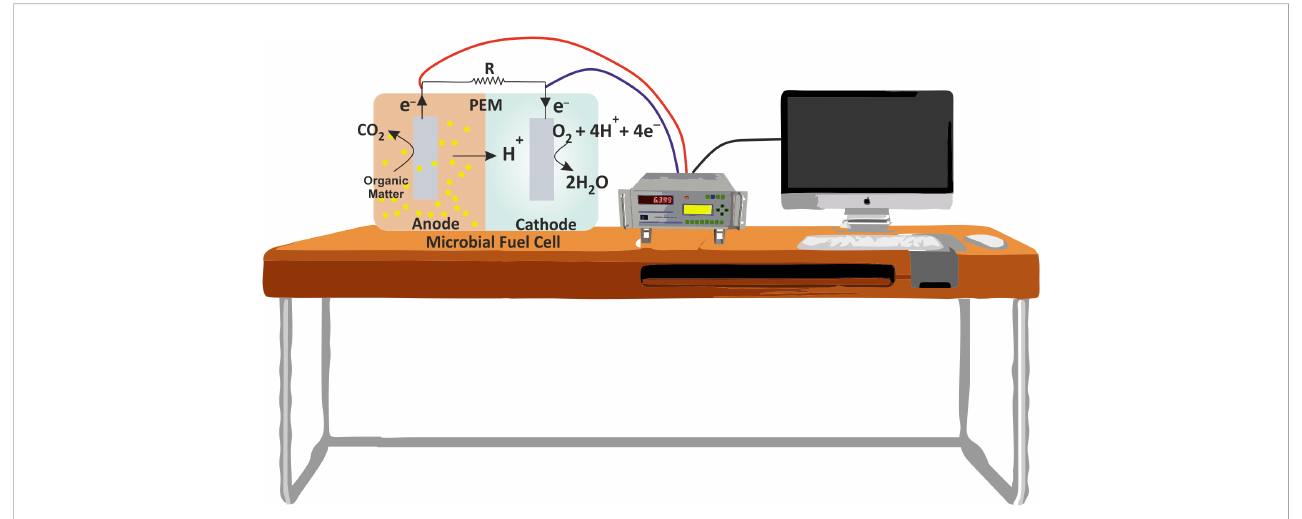
FIGURE 2 Schematic showing a typical MFC and its working principle. PEM, Proton exchange membraner and R,